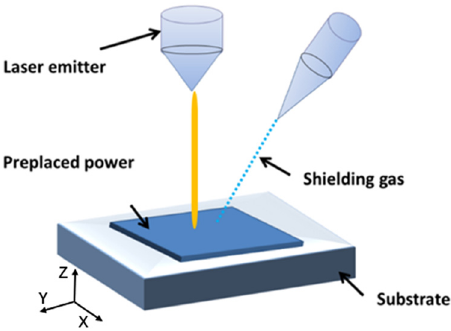
Figure 2: Schematic diagram of laser cladding